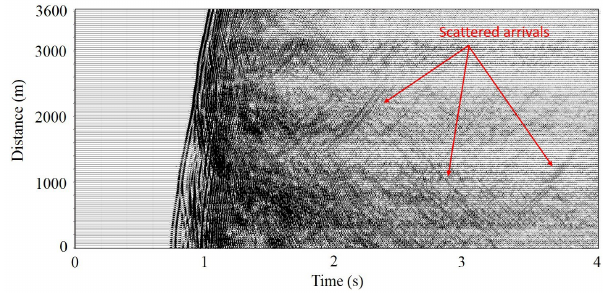
Figure 4. An example of synthetic seismogram (vertical compo- nent) of a plane wave that arrived with an incidence angle of 45 ◦ and propagated through the synthetic model (0–4s). The seismo- gram shows the first arrivals and numerous reflections. From about 1.5s, we can see scattered arrivals of different directions with appar- ent velocities of 2100–2500m/s. Several arrivals of scattered waves are indicated by red